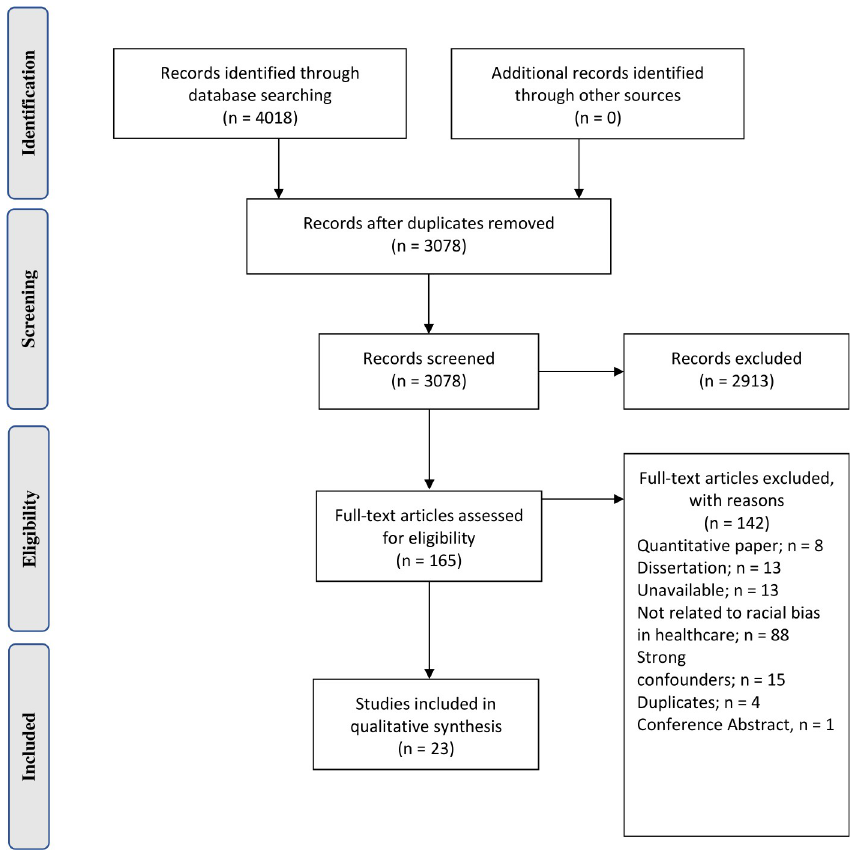
Fig 1. PRISMA flow